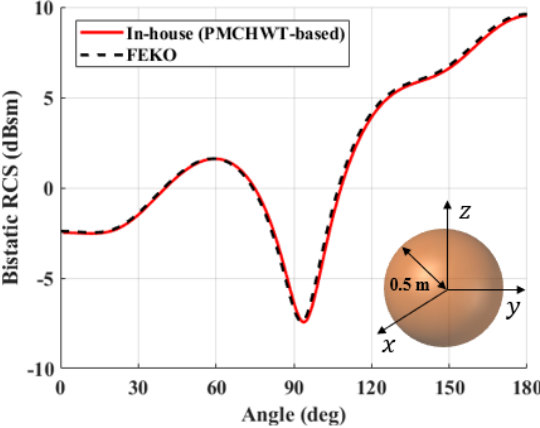
Figure 4. Bistatic RCS of a PEC sphere with radius of 0.5 m.